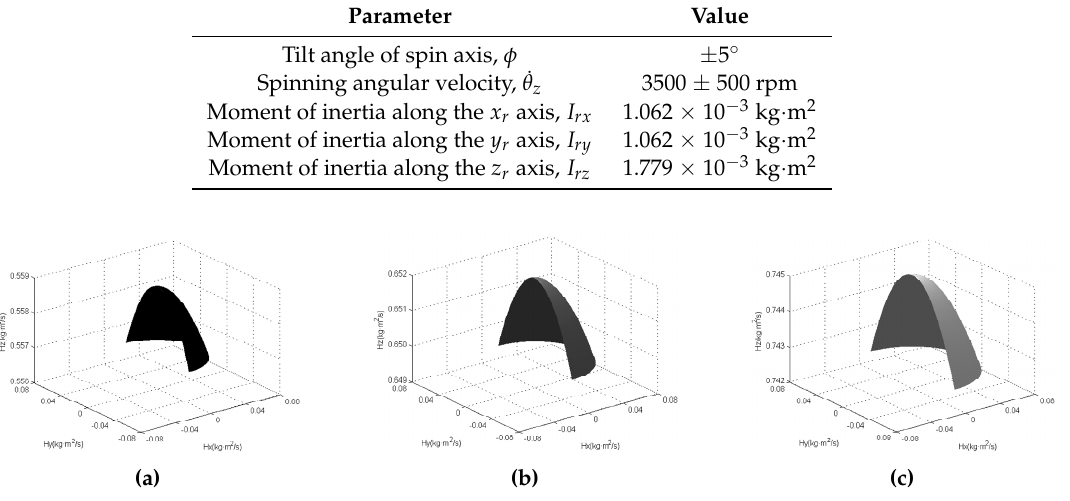
Figure 3. Angular momentum envelopes with different spinning angular velocities and limited